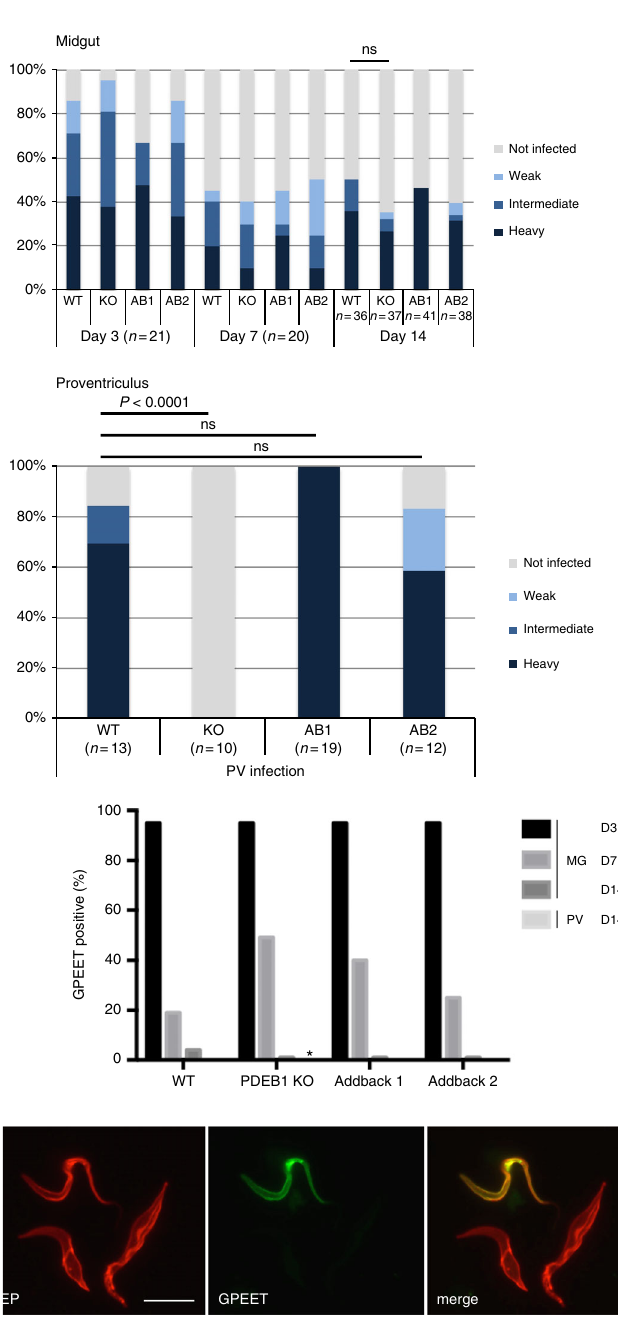
Fig. 5 Addback of PDEB1 restores invasion of the proventriculus. a Teneral fl ies were infected and the prevalence and intensity of infection were determined as described in Fig. 3a. Day 14 infection rate was not signi fi cantly different between WT and KO (ns, Fisher ’ s exact test, two- sided). b Prevalence and intensity of proventriculus infections in fl ies with